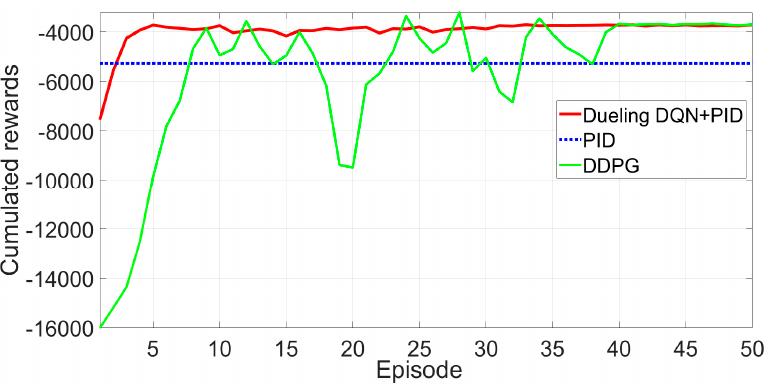
Figure 9. Learning curve for the hybrid algorithm, deep deterministic policy gradient (DDPG) with a fine-tuned Proportion Integration Differentiation (PID) as a benchmark (*a similar reward function is applied to the system equipped with the PID controller).